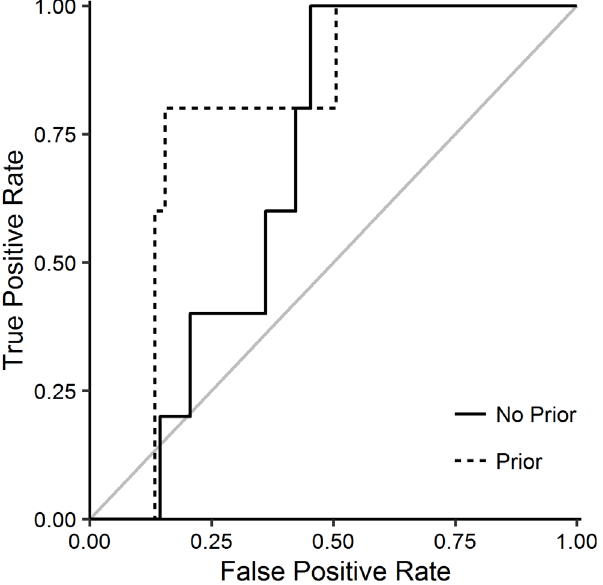
Fig 3. ROC curves for the analysis of the Pseudomonas data set, with (dashed line) and without (solid line) inclusion of a predictive prior.